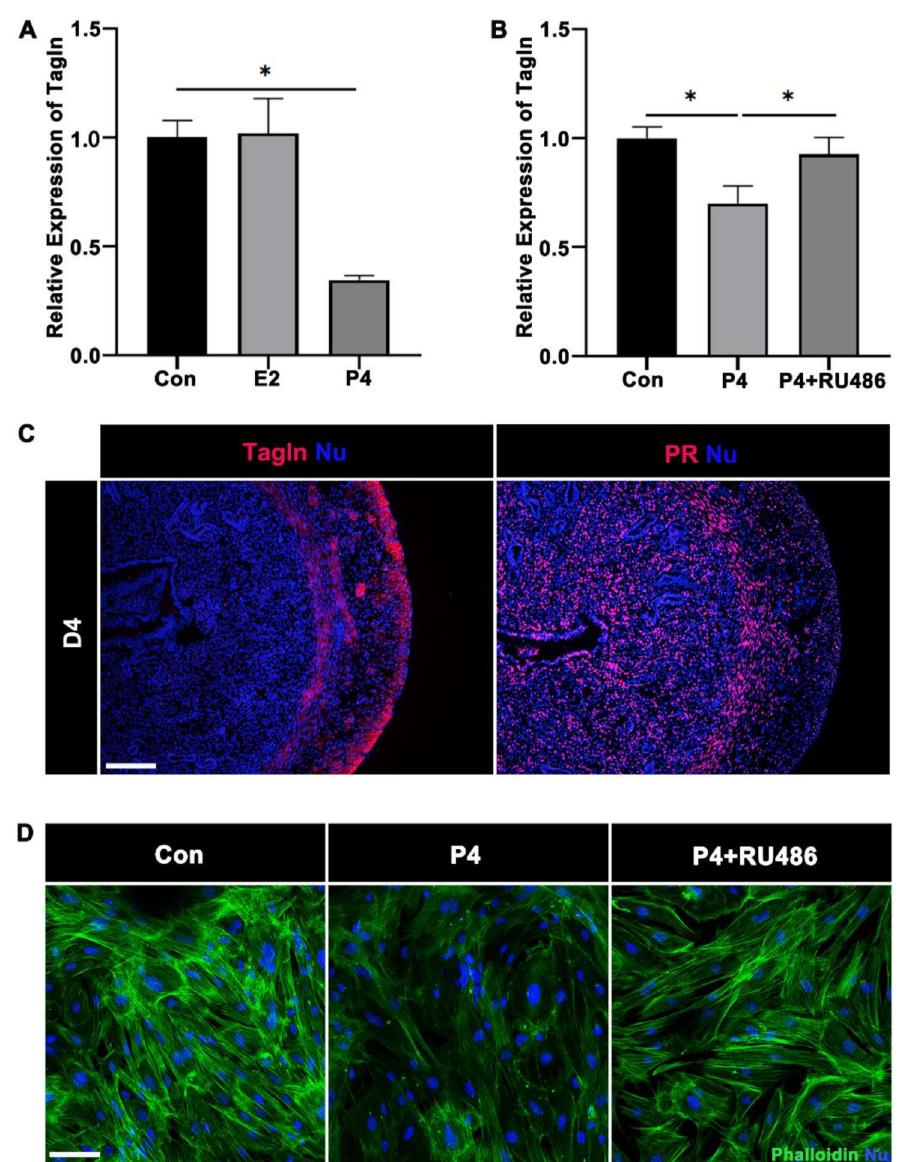
Figure 7. P4 regulates the expression of Tagln through PR. ( A , B ) The mRNA expression level of Tagln was measured at 20 nM E2, 100 nM P4, and 1 µ M RU486 + P4 for 48 h of uterine SMCs on day 4 of pregnancy, * p < 0.05. ( C ) Immunofluorescence of Tagln (red) and PR (red) with continuous mice uterine slices on day 4 of pregnancy. Scale bars = 200 µ m. ( D ) Phalloidin staining (green) of mouse uterine SMCs on day 4 of pregnancy treated with 100 nM P4, 1 µ M RU486 + P4 for 48 h. Scale bars = 200 µ